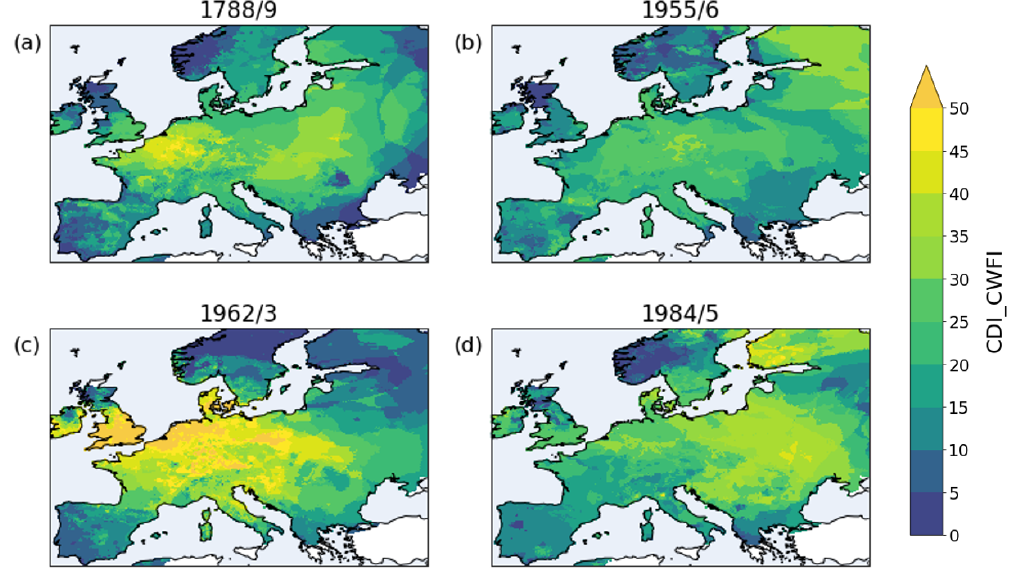
Figure 8. Cold-spell days index with reference to the 10th percentile of the daily mean temperatures for the period 1950–2020. The cdi_cwfi is calculated over the winter months NDJF for the following extreme winters: 1788/89 (a) , 1955/56 (b) , 1962/63 (c) , and 1984/85 (d) . The first of these is from the post-processed temperature reconstruction, while information for the 20th century winters is taken from the E-OBS dataset. Table 2. Detected cold spells for the winters 1788/89, 1955/56, 1962/63, and 1984/85 below the 1st percentile of mean daily temperature in the period 1950–2020, all averaged over central Europe (2–25 ◦ E, 44–55 ◦ N). The duration of the cold spell in days as well as its start, peak, and end dates are shown; for each event the mean and maximum intensity ( ◦ C) are also shown relative to the seasonal climatology as well as the rate of onset and decline of the event ( ◦ Cd − 1